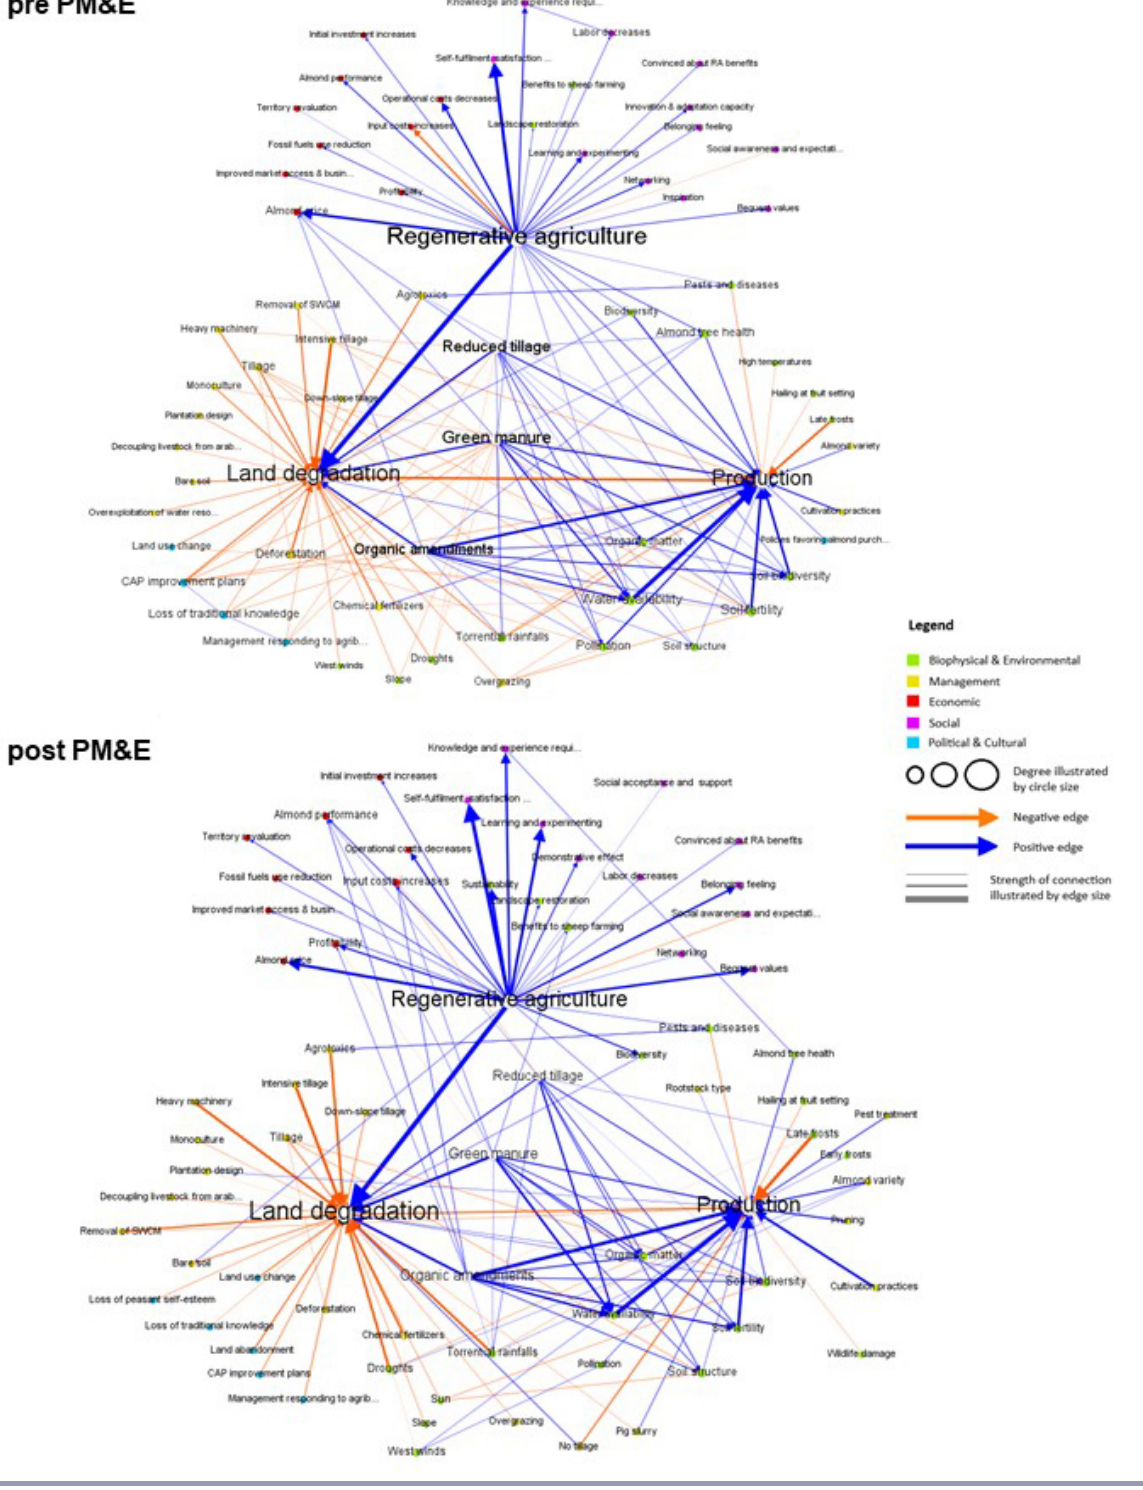
Fig. 3. Combined fuzzy cognitive maps of farmers pre and post (in the third year) participatory monitoring and evaluation (PM&E). N = 10 farmers. Circle size indicates the relative centrality score of each factor. Arrow thickness represents the relative strength of the connection. Arrow color indicates connections, i.e., influences of one factor on another factor: blue = positive, orange =